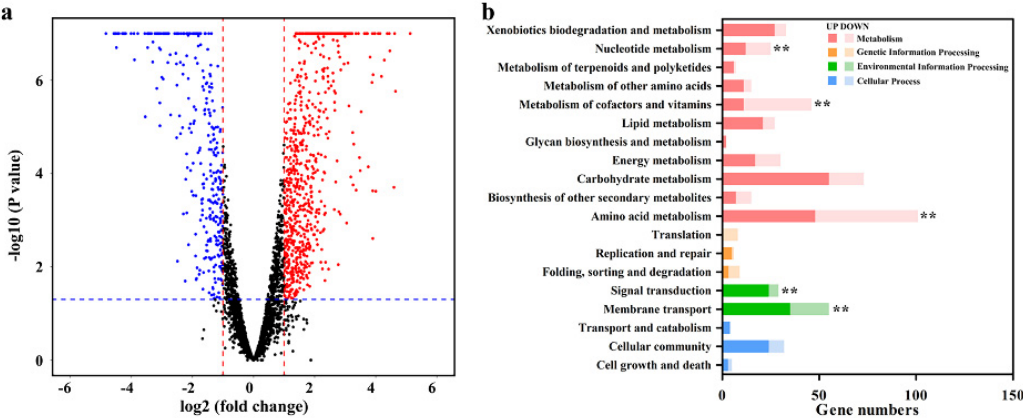
Figure 5. Volcano plot ( a ) and KEGG enrichment analysis ( b ) of DEGs from strain ZM05 in the monoculture system or